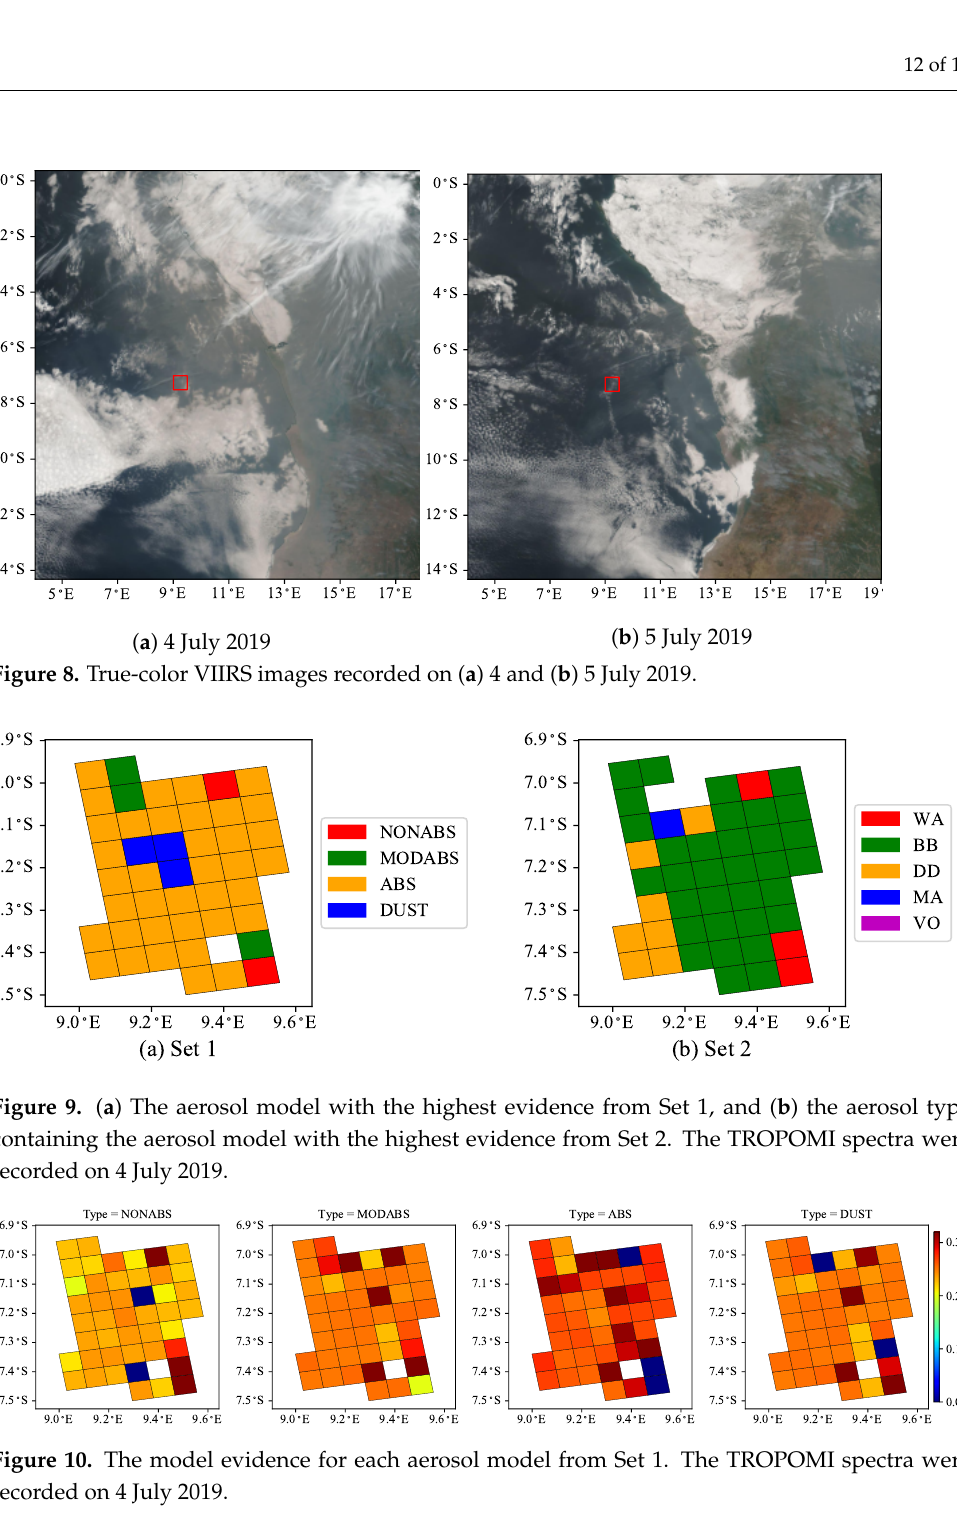
Figure 10. The model evidence for each aerosol model from Set 1. The TROPOMI spectra were recorded on 4 July